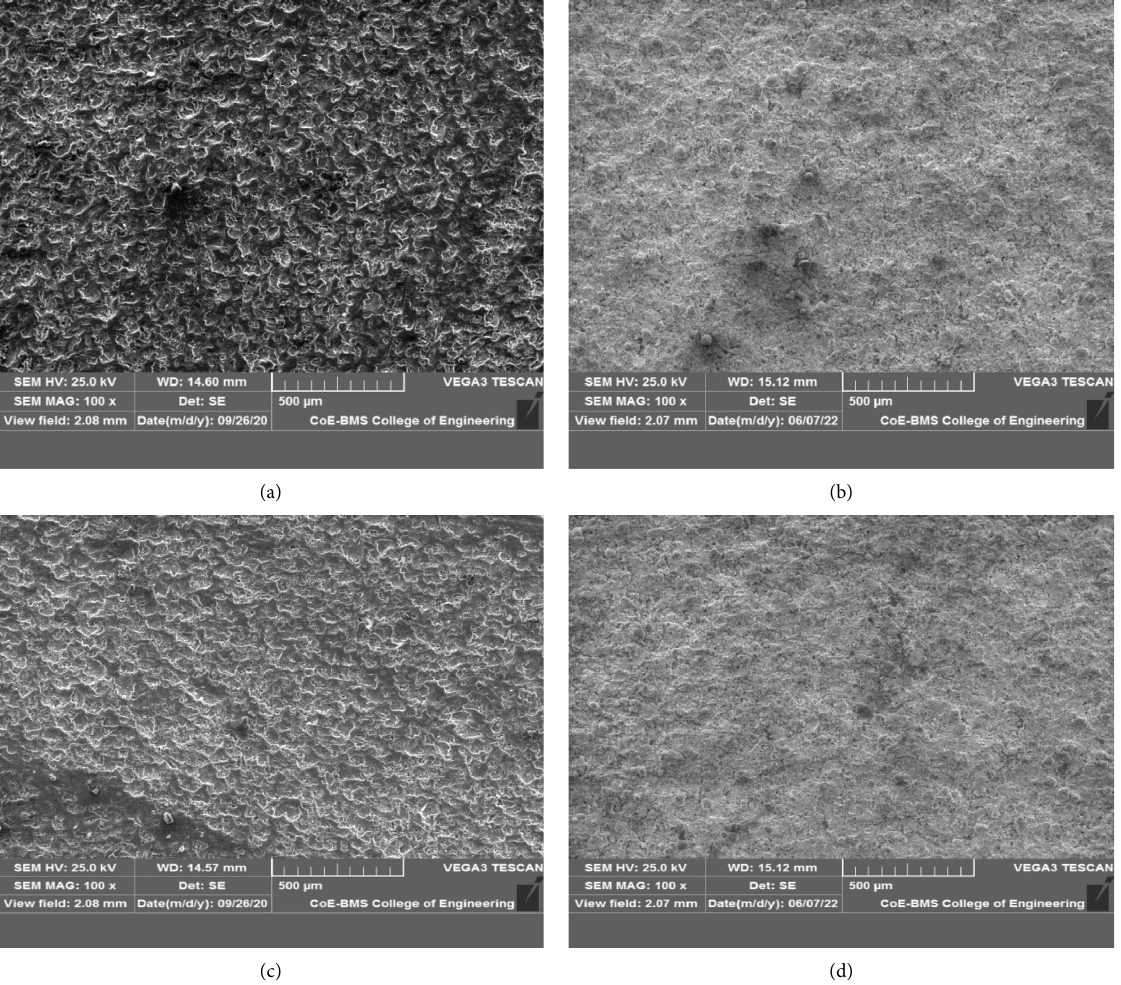
Figure 13: SEM of slurry eroded surfaces at diferent particle size: (a) Al6061 alloy (210 microns), (b) coatings (210microns), (c) Al6061 alloy (625 microns), and (d) coatings (625